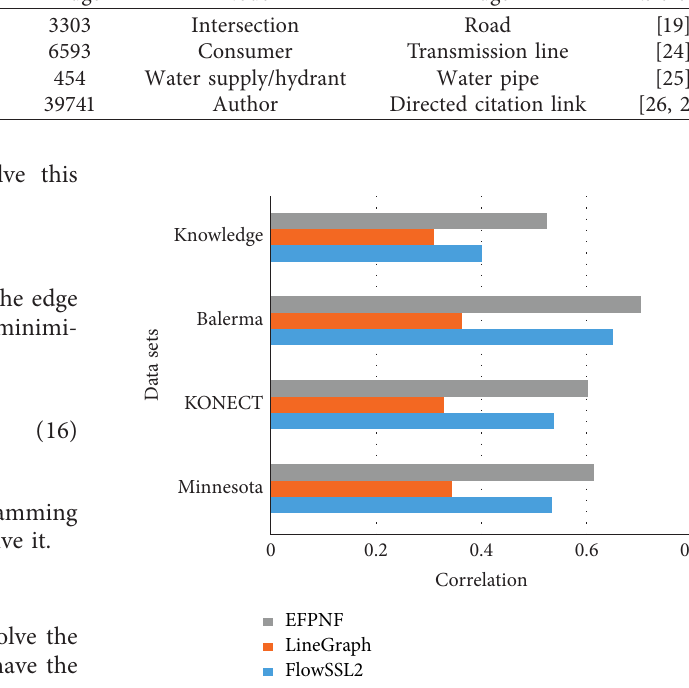
Figure 2: Comparison results over